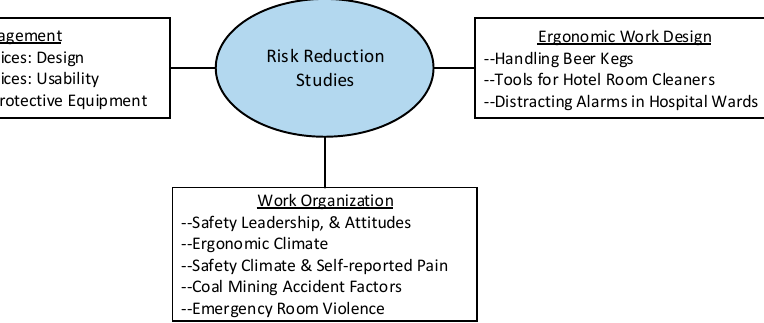
Figure 1. Depiction of how content of the papers in this Special Issue contributed to the body of knowledge regarding occupational safety and health.